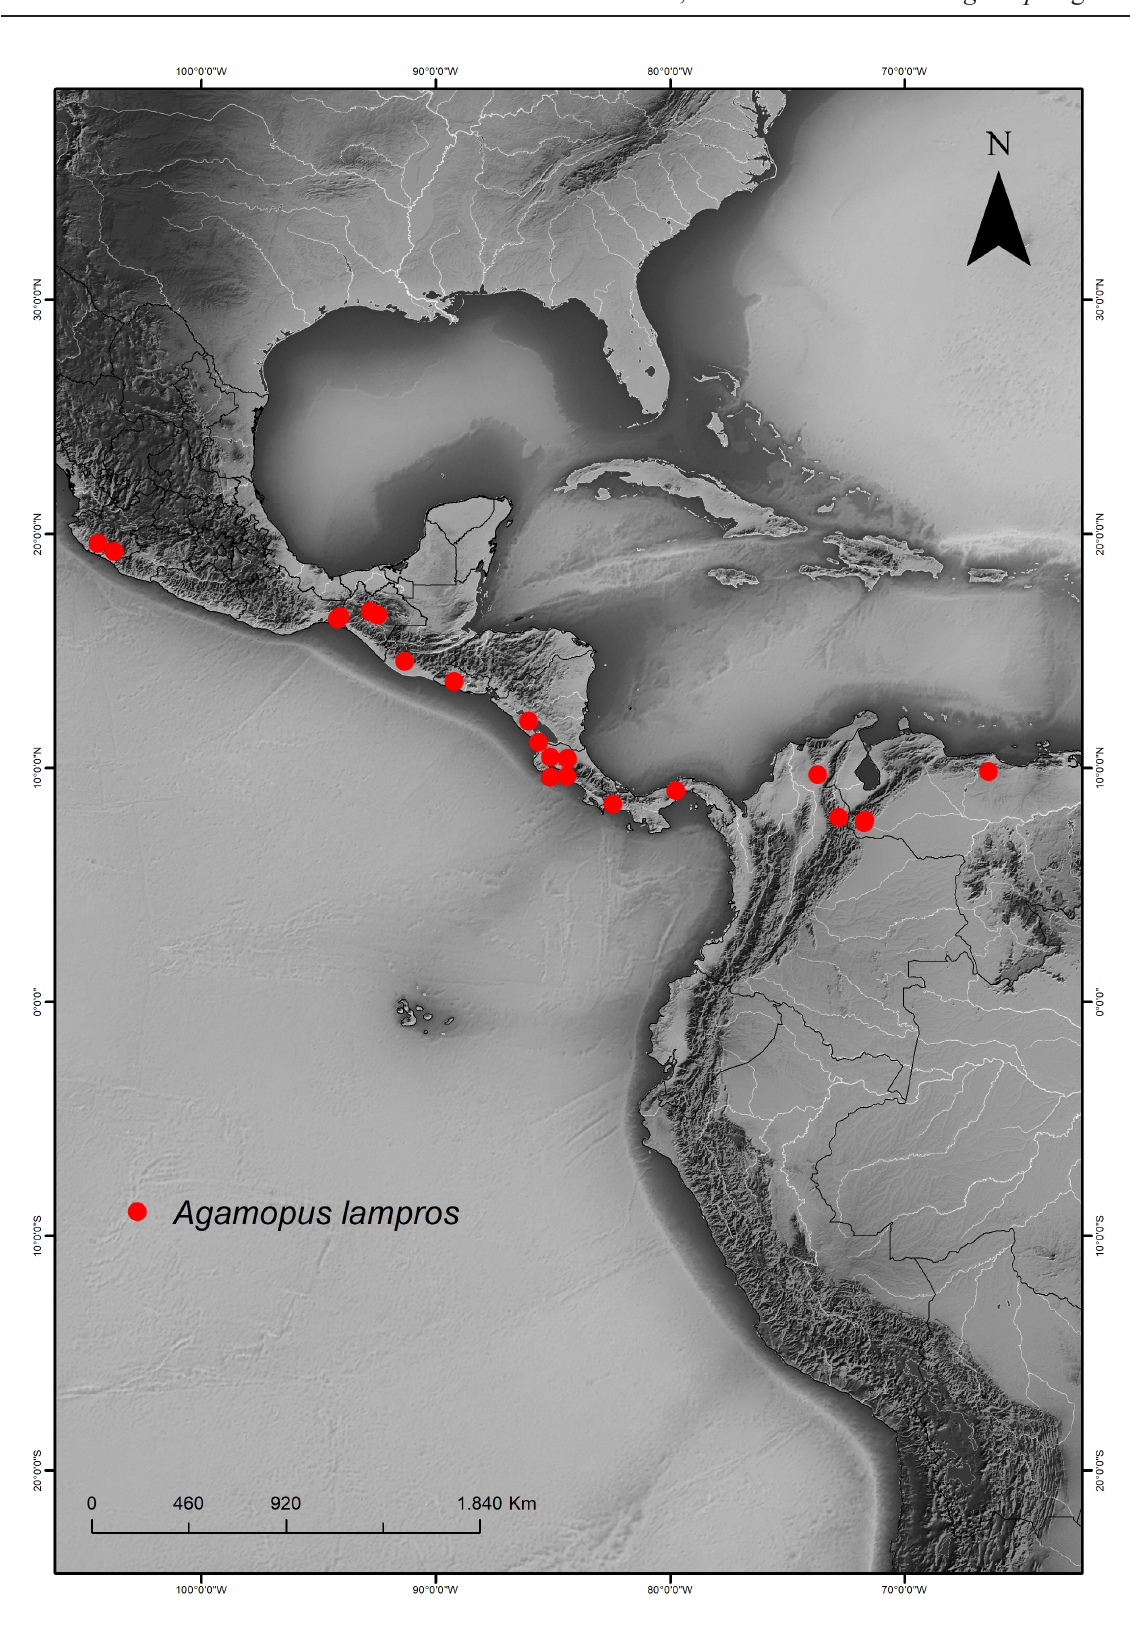
Fig. 7. Geographical distribution map of Agamopus lampros Bates, 1887